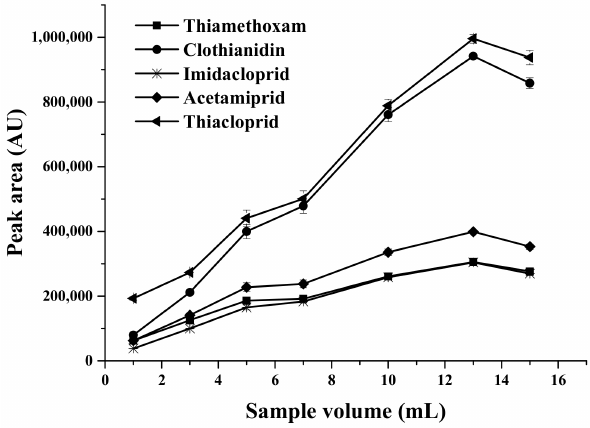
Figure 2. Effect of sample volume on the extraction efficiency, using 30 mg MMT sorbent, 0.1 g of Na 2 SO 4 , and 200 µ L of acetonitrile as desorption